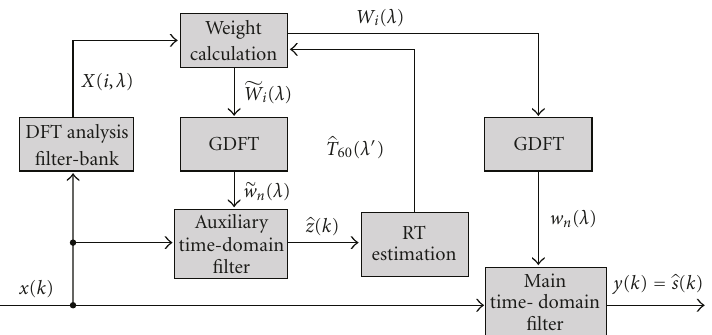
Figure 1: Overall system for low delay noise reduction and dereverberation. The frequency warped system is obtained by replacing the delay elements of the analysis filter-bank and both time-domain filters by allpass filters of first